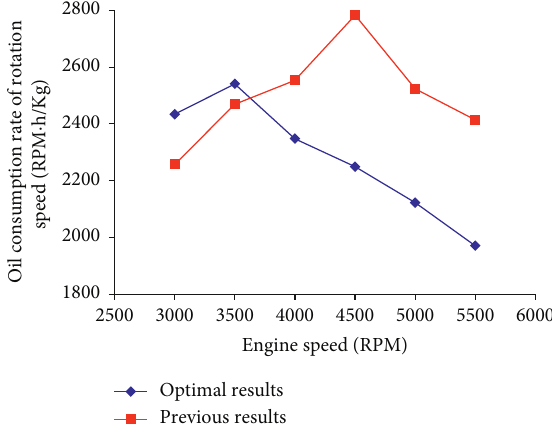
Figure 20: Comparison results of the optimal and previous oil consumption rate of the engine